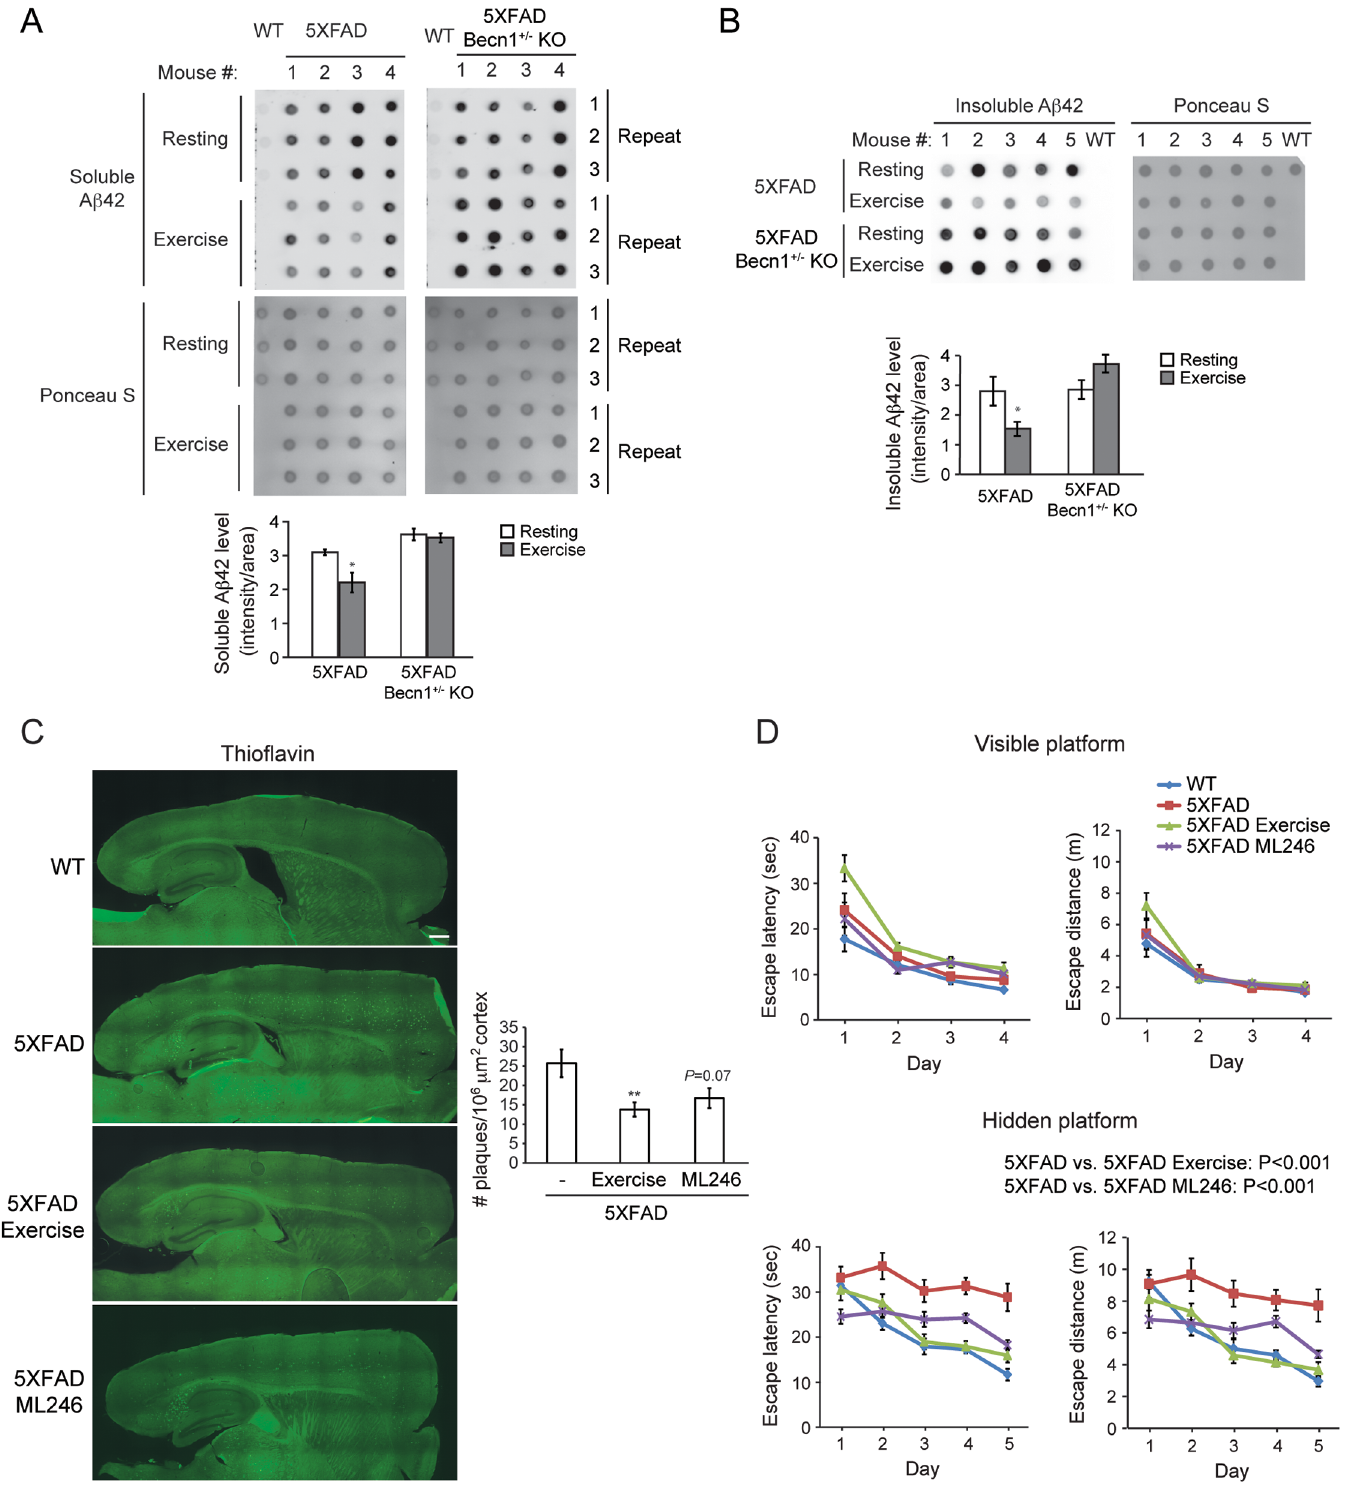
Fig 7. ML246 and voluntary exercisedecreasecerebral amyloid plaques and ameliorate memory deficits in 5XFAD AD mice. (A, B) Representative images (upper)and quantification (lower) of dot-blot assays on soluble (A) and insoluble (B) A β 42 levels in brain samples of 6-month old 5XFAD and 5XFAD Becn1 +/- KO mice after 4 months of voluntary running,immunostained with anti-A β 42 antibody. Total protein loadingwas labeledby Ponceau S. Triplicate experiments from 4–5 mice in each group were shown. (C) Representative images (left) and quantification (right) of amyloid depositsstainedby ThioflavinS